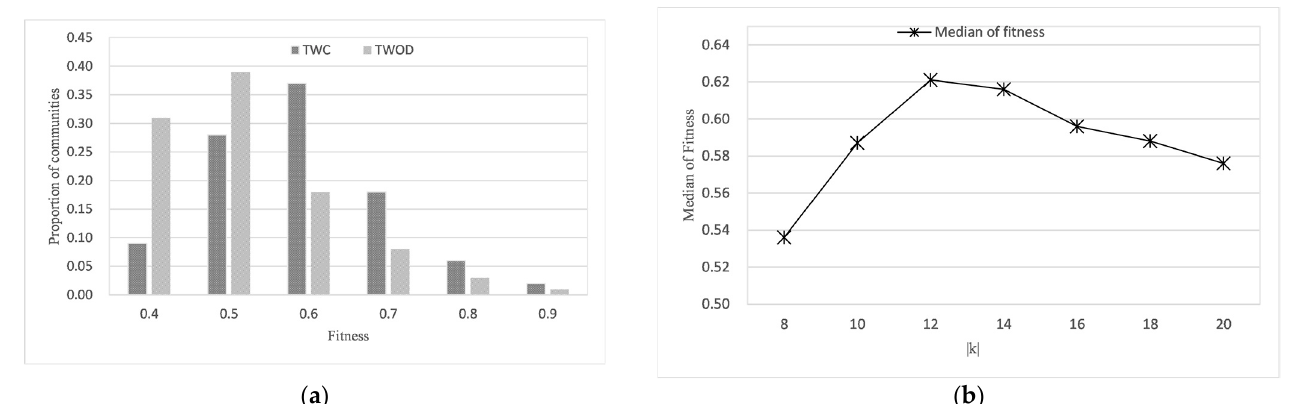
Figure 4. Community fitness comparison. ( a ) Proportion of communities in different fitness ranges when k = 10; ( b ) median of community fitness with different k. when k = 10; ( b ) median of community fitness with different k